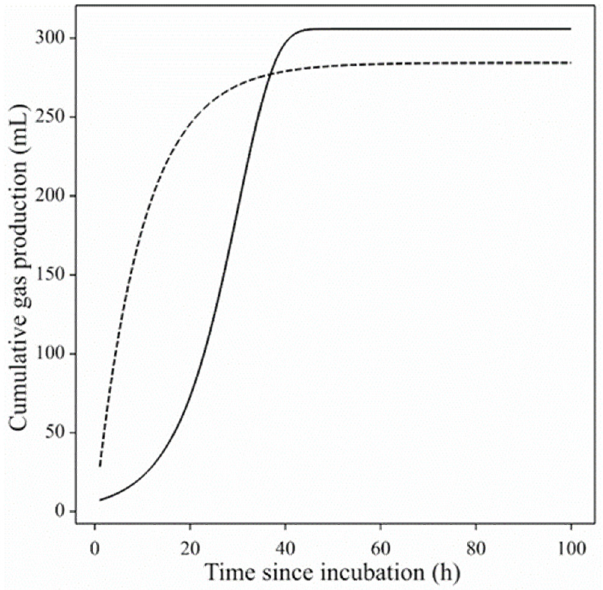
Figure 1. Typical gas production profiles (Mould et al. [13]). The fitted profiles were produced using 200 mg of a pure substrate [glucose (dashed line) and cellulose (solid line)] and 10 mL of a standard rumen fluid inoculum.